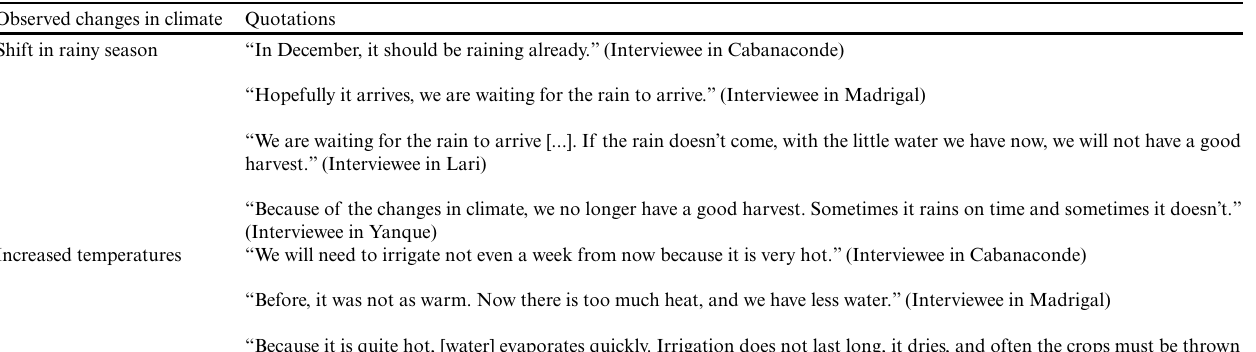
Table 2 . Quotations from farmers regarding observed changes in climate. Observed changes in climate Quotations